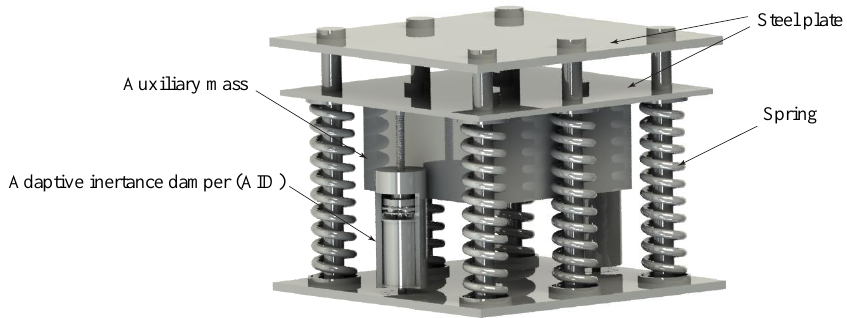
Figure 1. Perspective view of the adaptive tuned mass inertance damper (ATMID).